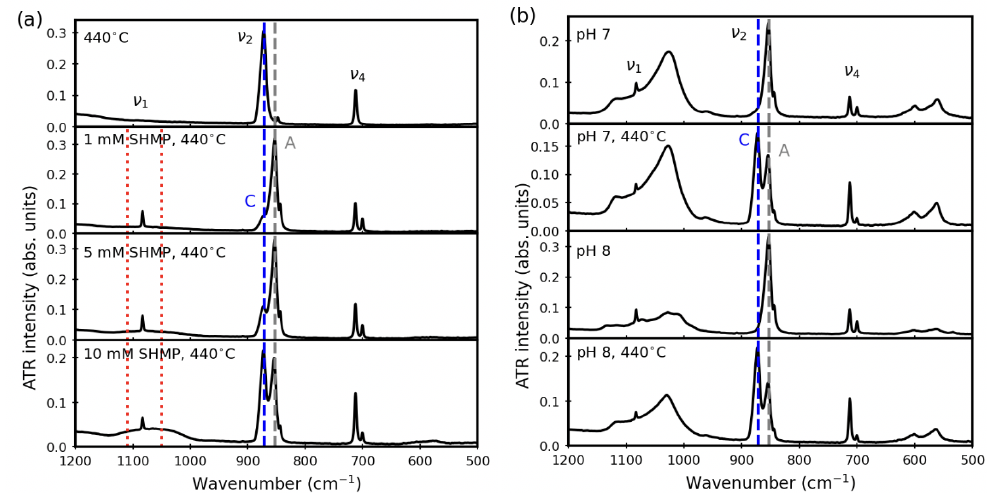
Figure 7. Representative ATR-FTIR data for samples annealed at 440 ◦ C after aqueous treatment in either ( a ) SHMP (1, 5, 10 mM) or ( b ) orthophosphate (pH 7 or pH 8, both at 10 mM). The grey vertical line (858 cm − 1 , labeled A) corresponds to the aragonite ν 2 peak, while the blue vertical line (875 cm − 1 , labeled C) shows the calcite ν 2 peak. The red-dotted lines indicate poorly crystalline phosphate secondary phases.